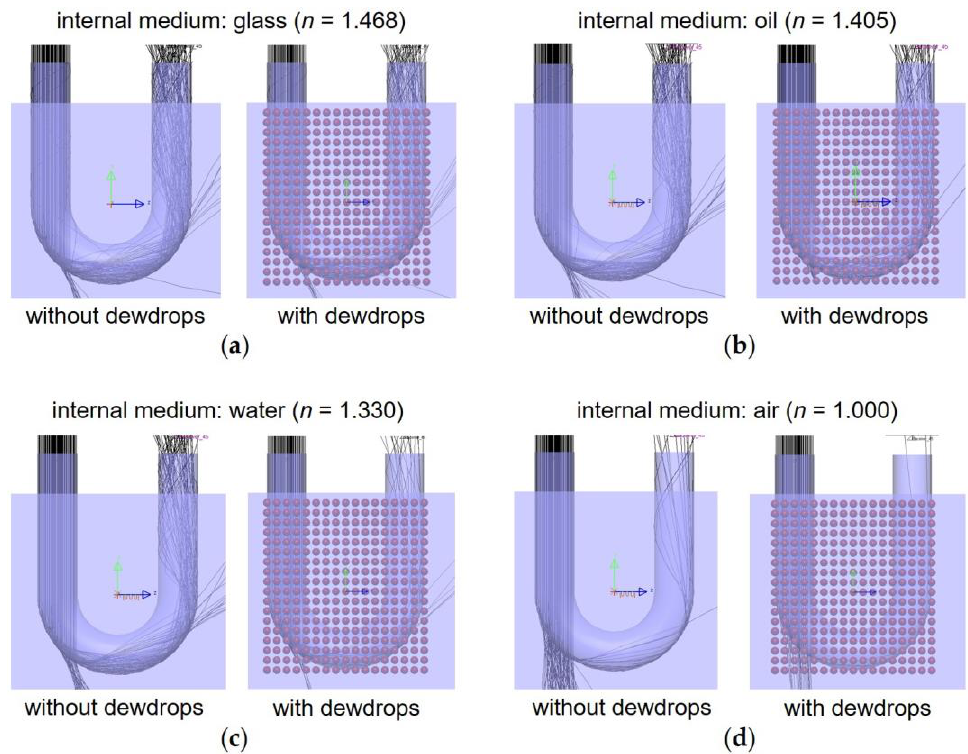
Figure 3. Optical simulation results (the light wavelength: 650 nm). Optical paths obtained with various internal media for the waveguide, i.e., ( a ) glass, ( b ) oil, ( c ) water, and ( d ) air.